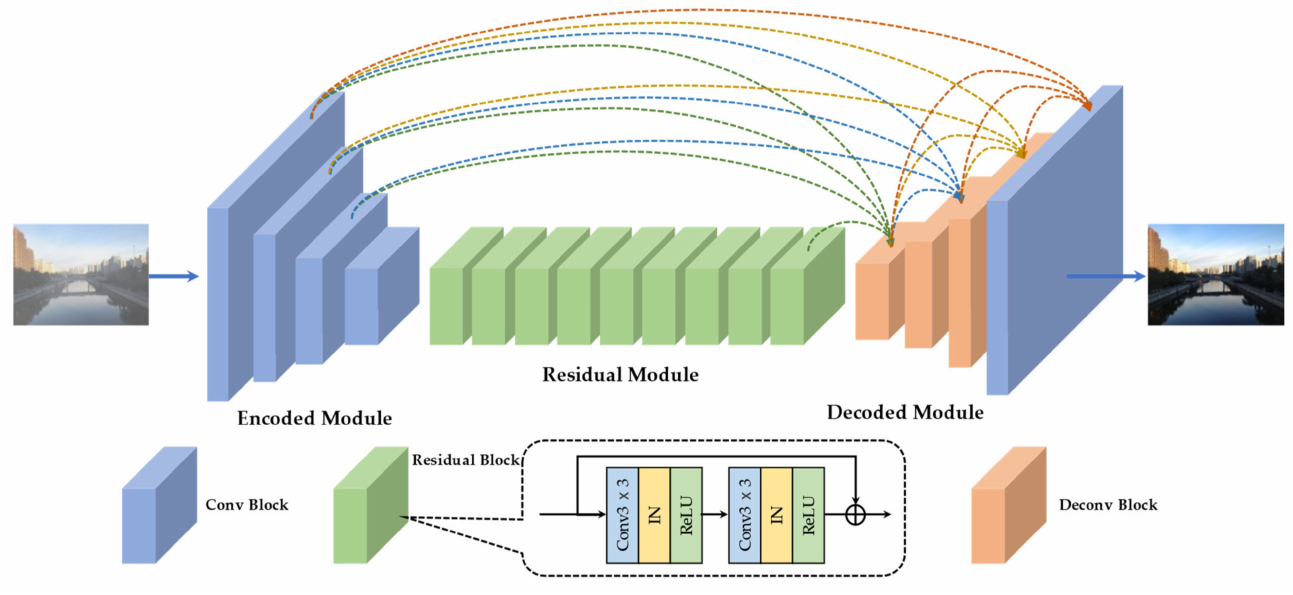
Figure 2. The specific structure of the